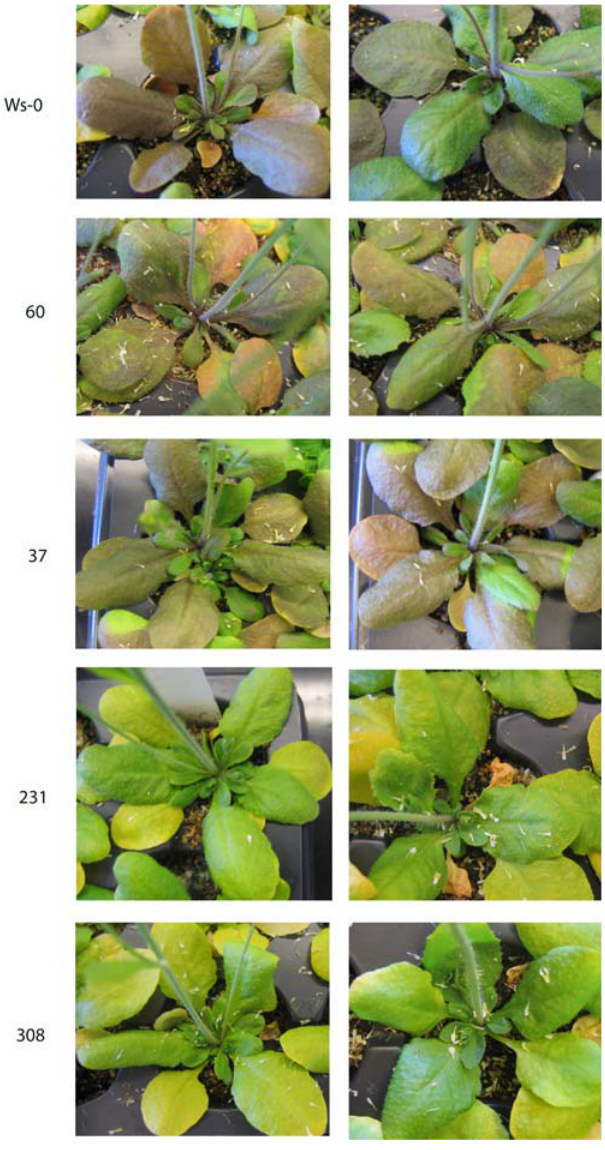
Figure 2. Anthocyanin accumulation in rosette leaves of wild- type A. thaliana Ws-0 and CHS hairpin interfering transgenic lines. Diploids (left) and tetraploids (right) were incubated in CHS inducing conditions for 15 days. The transgenic line numbers are indicated on the left.